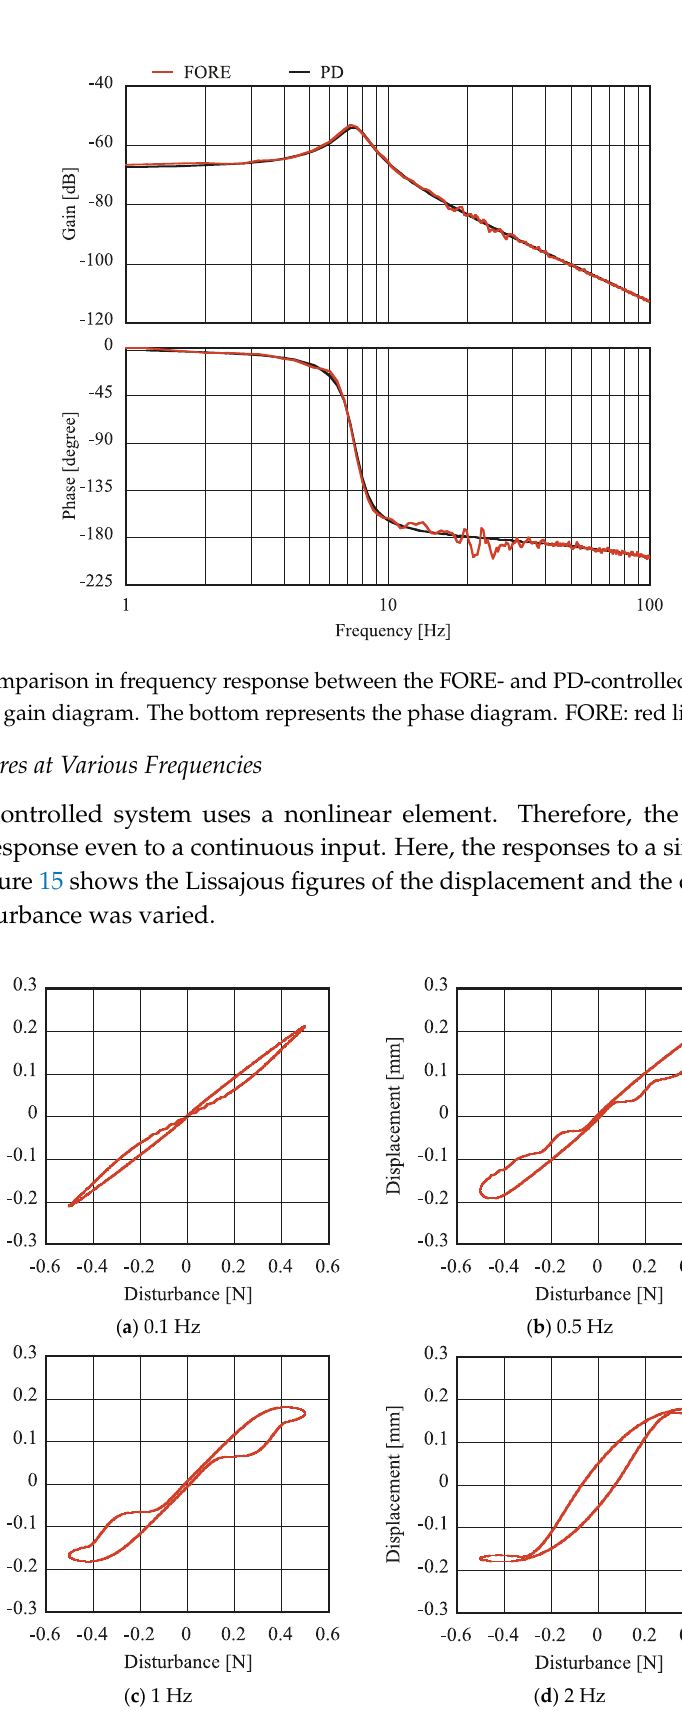
Figure 15. Lissajous figures of displacement and sinusoidal disturbance.